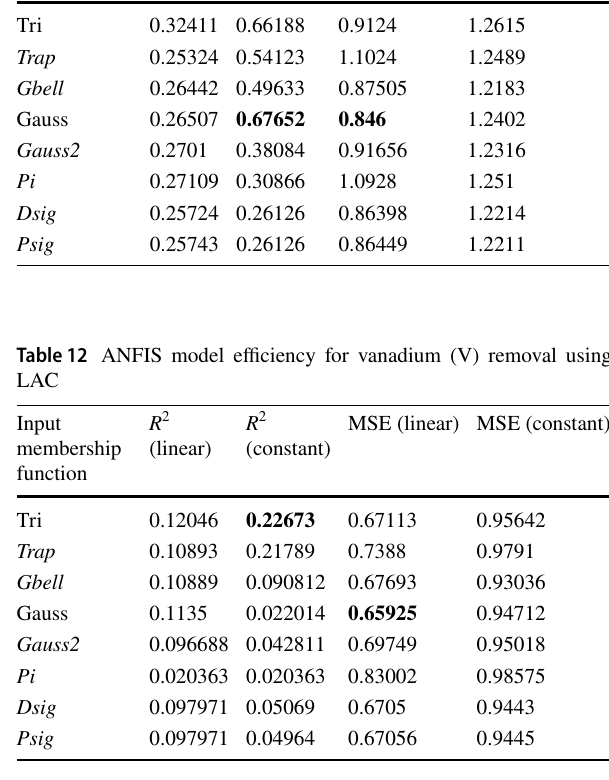
Fig. 11 R 2 (ANFIS) for iron (II)